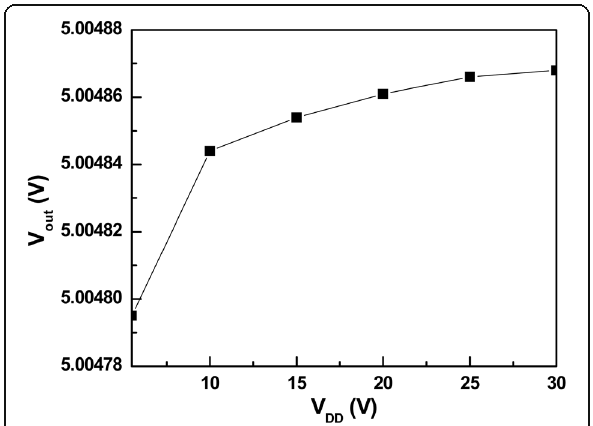
Fig. 12 Line regulation of proposed VR